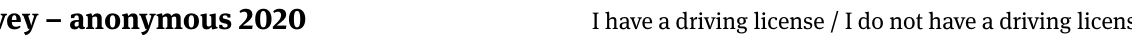
Table 1: Form of the